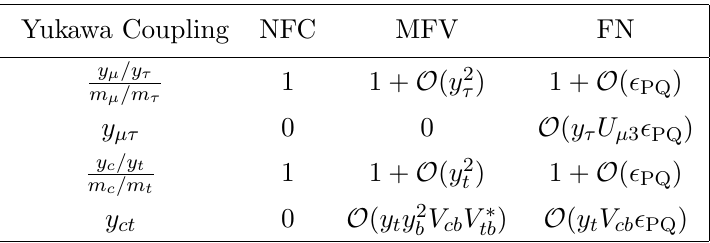
Table 1. Examples of deviations from proportionality and diagonality in the NFC, MFV and FN frameworks. (For leptonic MFV we assume here that Y e is the only spurion.)